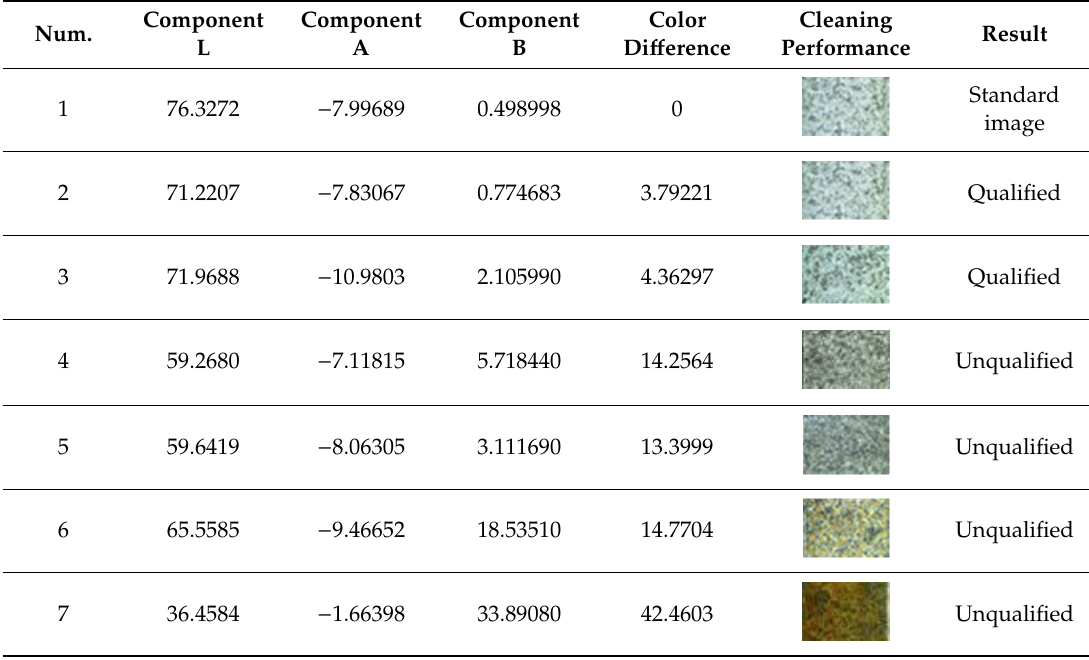
Table 3. Color difference of workpieces after cleaning. Num.